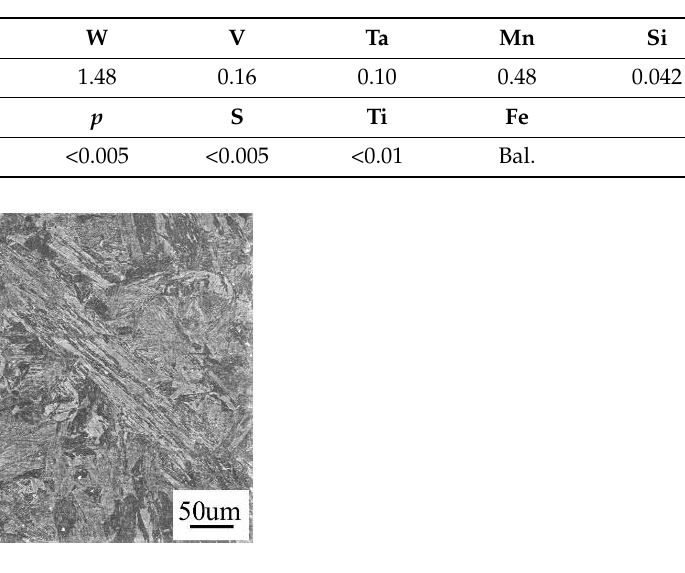
Figure 3. Microstructure of CLAM showing tempered martensite.